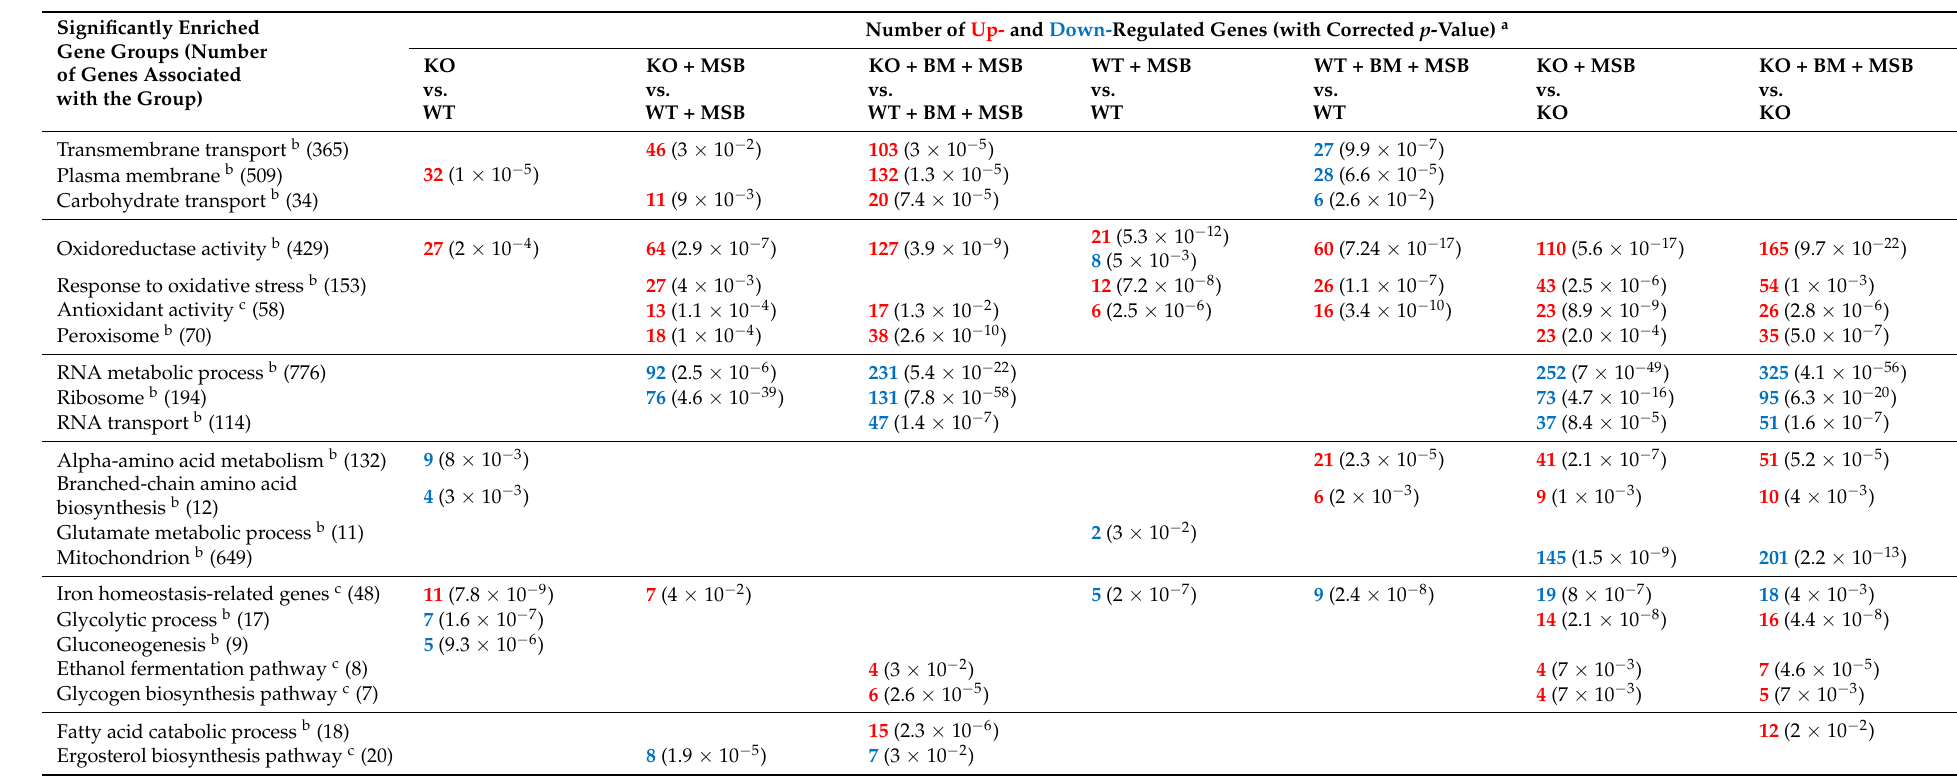
Table 2. Summary of gene enrichment analyses.